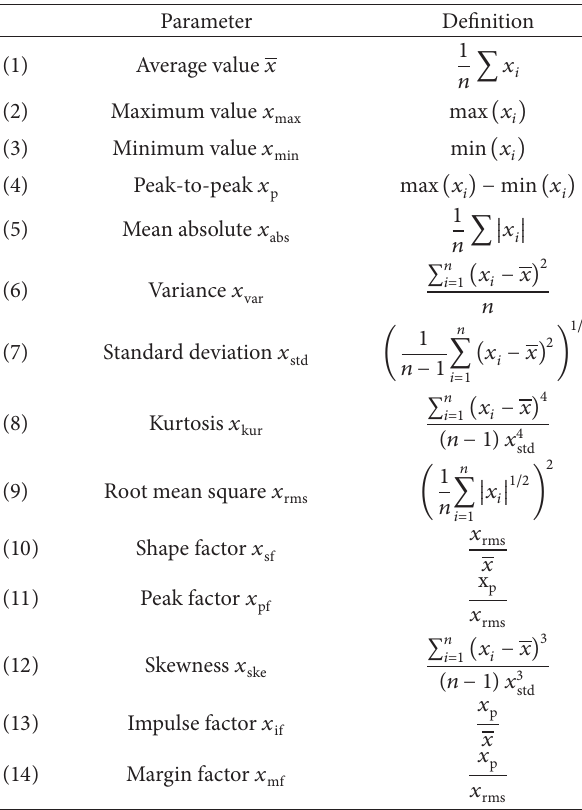
Table 3: Statistics features in time domain.